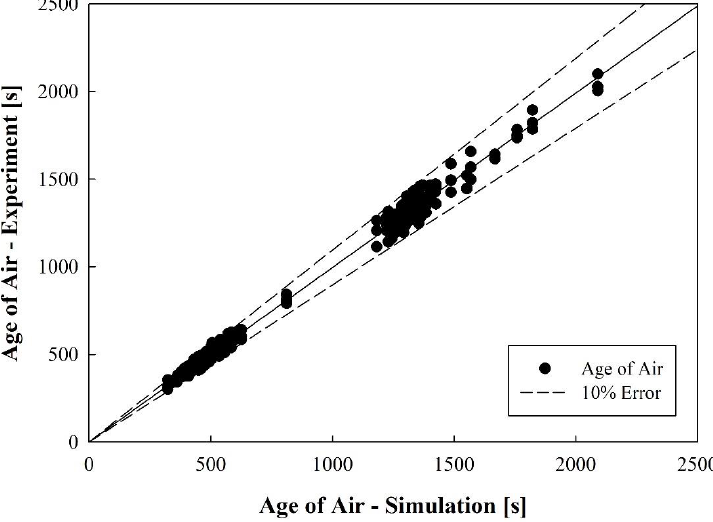
Figure 5. Comparison of the age of air between experimental measurements and numerical analysis.